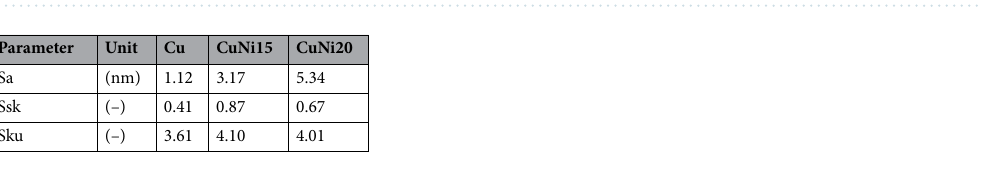
Figure 3. Particle diameter size distribution of ( a ) Cu, ( b ) CuNi15, and ( c ) CuNi20 thin films were obtained from the AFM topographical maps.